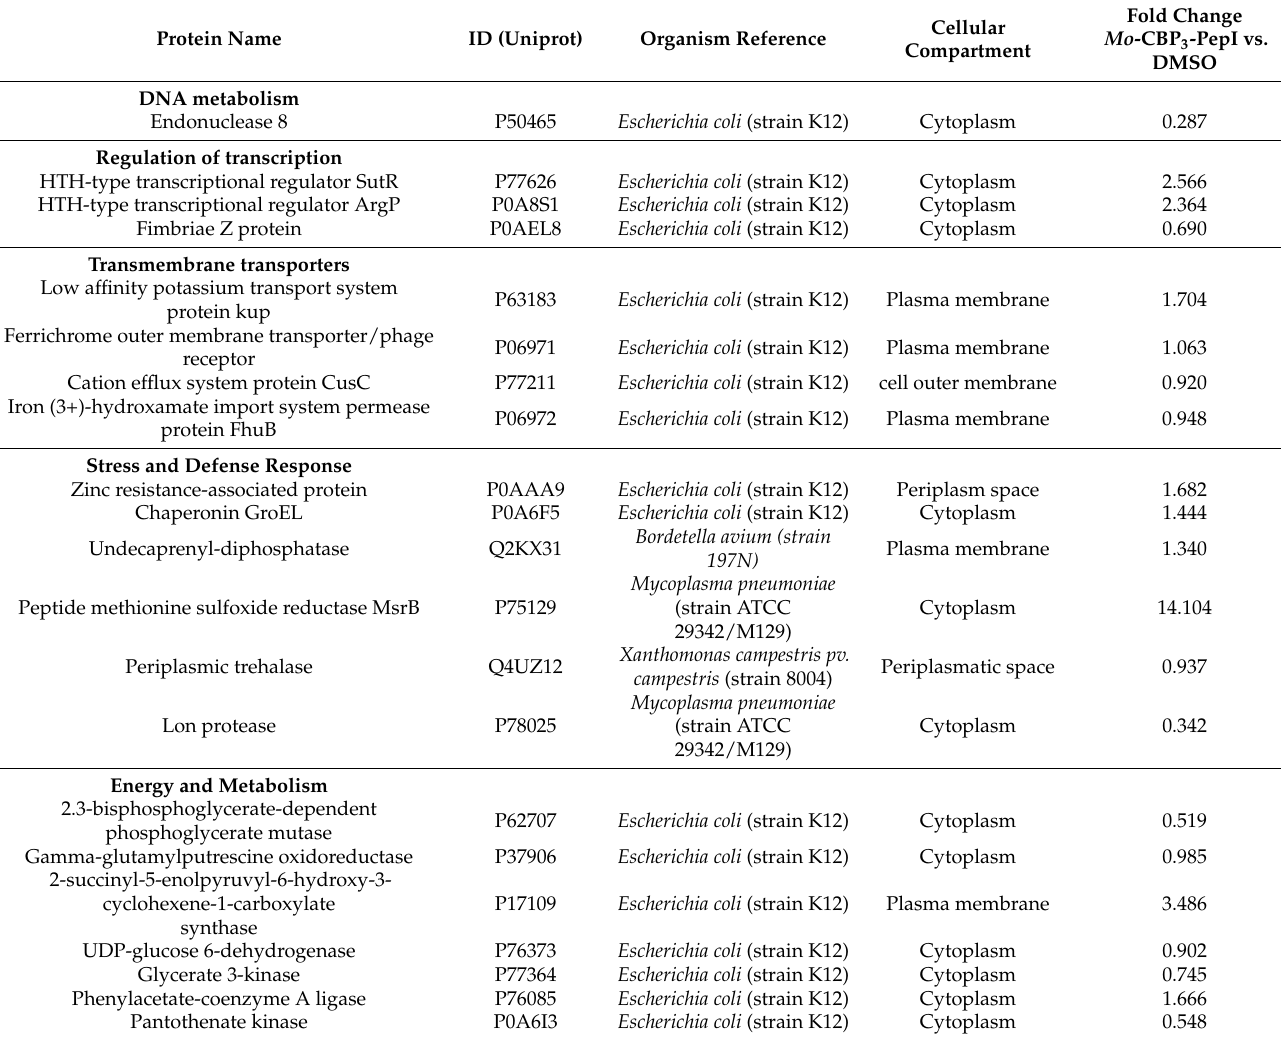
Table 2. Differentially accumulated proteins identified by ESI-LC-MS/MS.